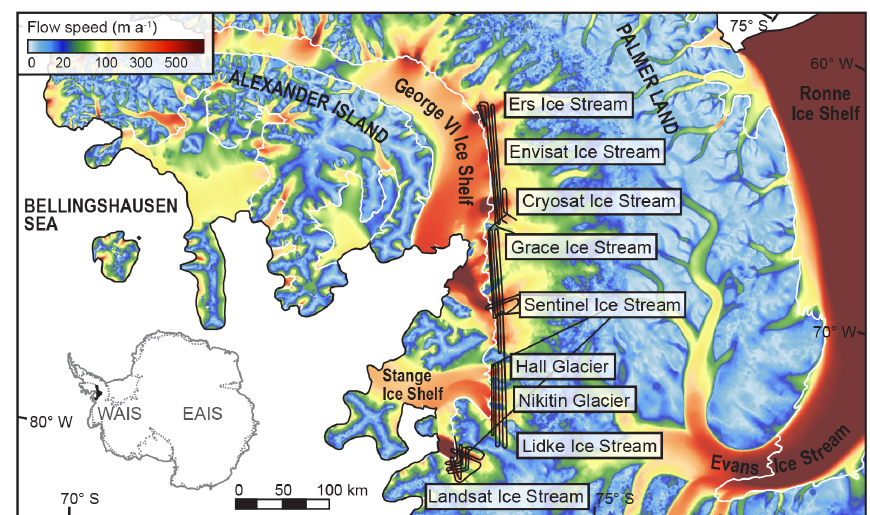
Figure 1. Airborne radio-echo sounding surveys (RES) (black lines), collected during the austral summer of 2016/2017, transcend the Bellingshausen Sea sector of Palmer Land in the Antarctic Peninsula. RES surveys transect several glaciers and ice streams along the English Coast at or close to the Antarctic Surface Accumulation and Ice Discharge (ASAID) grounding line (white line) (Bindschadler et al., 2011), after which the ice floats. Background imagery shows surface flow speeds from MEaSUREs (Mouginot et al., 2019a). The inset map shows the location of RES surveys used in this paper (black), superimposed on a map of